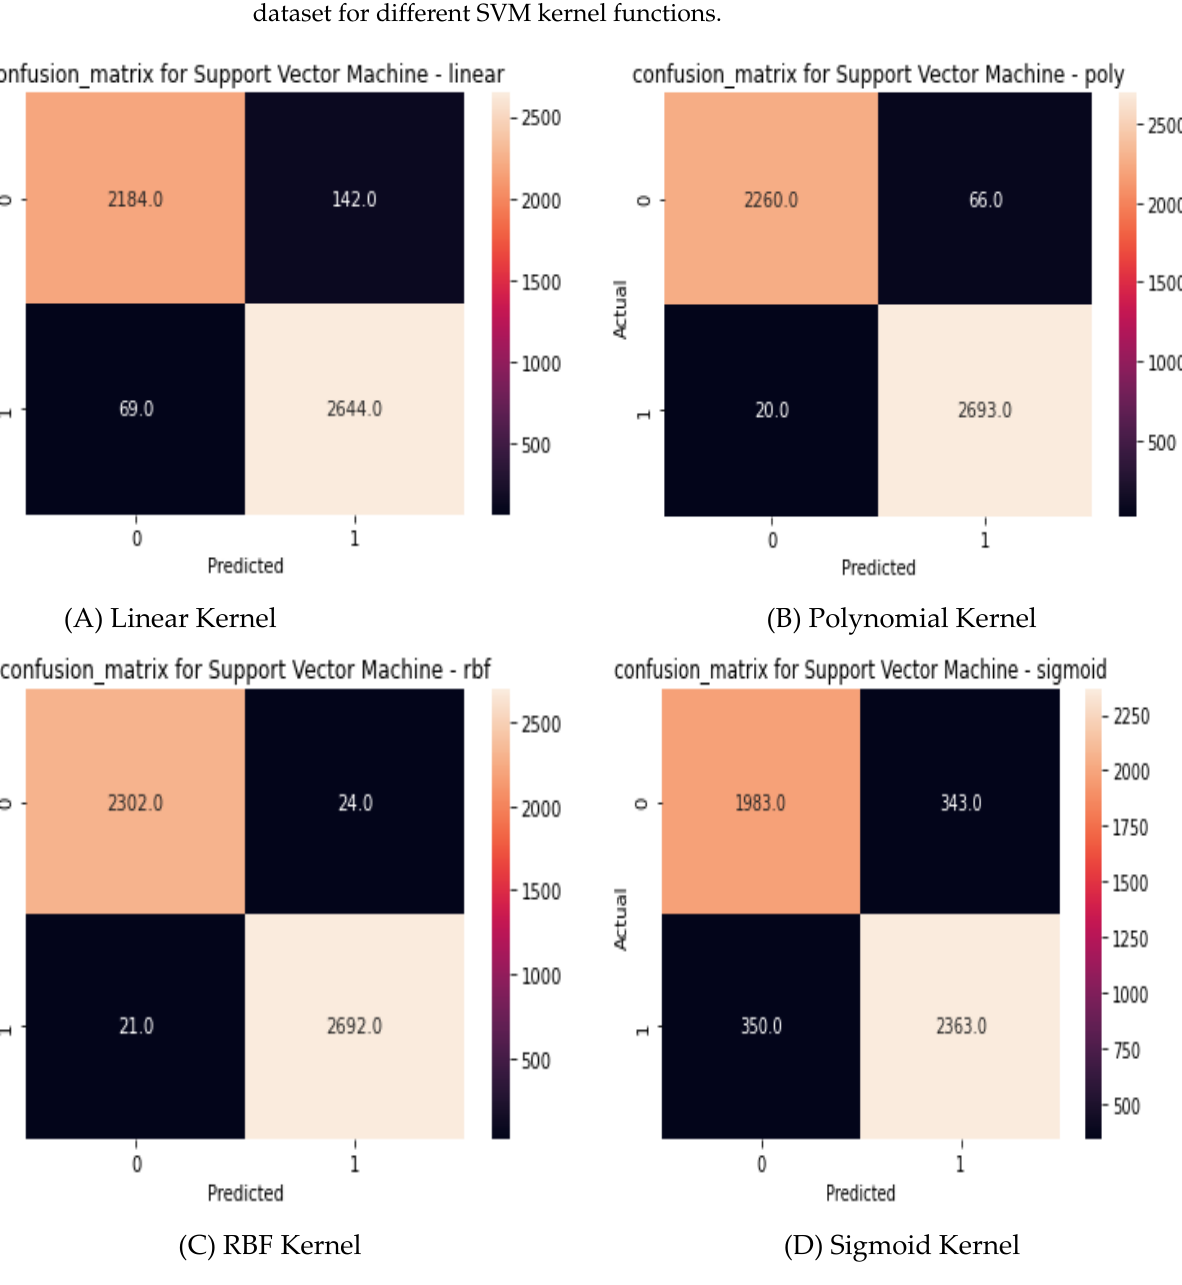
Figure 5. obtained confusion matrix of KDD CUP’99. Figure 5. Obtained confusion matrix of KDD